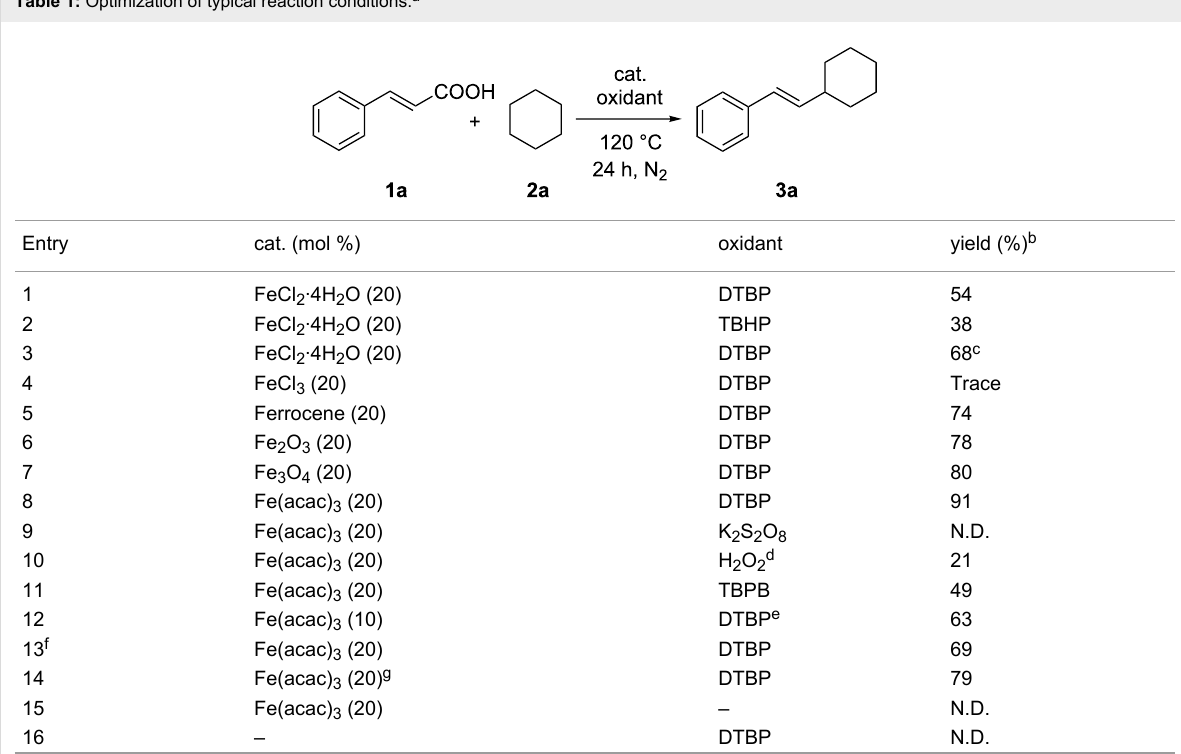
Table 1: Optimization of typical reaction conditions.